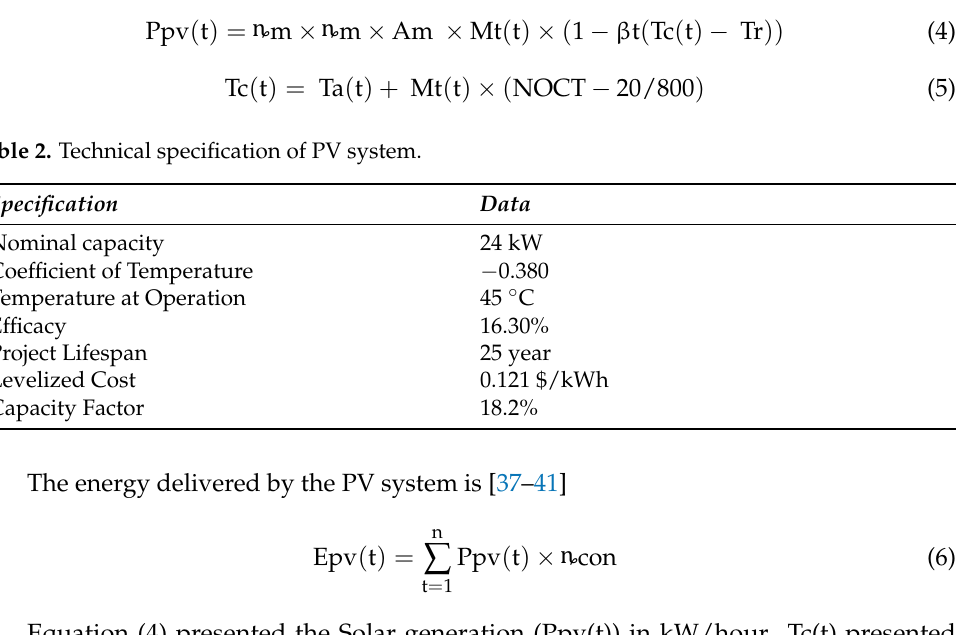
Table 1. The Electricity Tariffs in Indonesia [35].